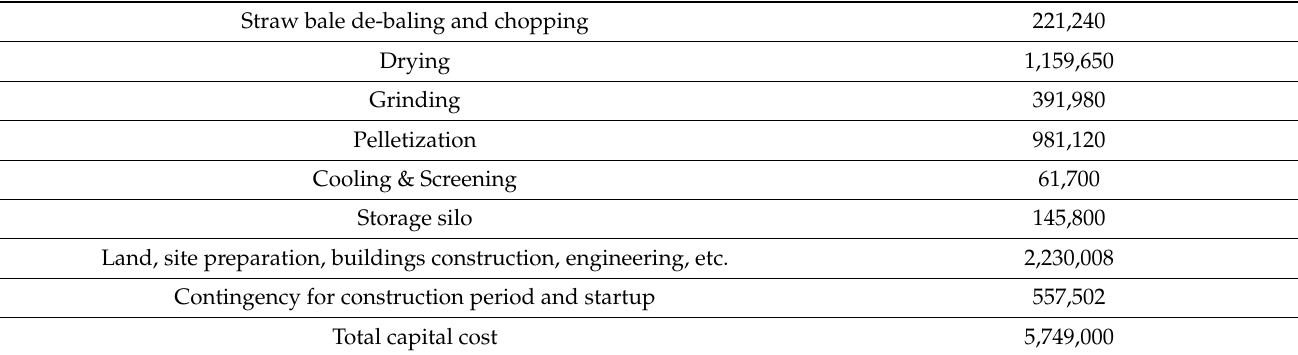
Table A2. Capital cost of the ag-pellet plant with a capacity of 5 tonne/h (43,800 tonne/year). Straw bale de-baling and